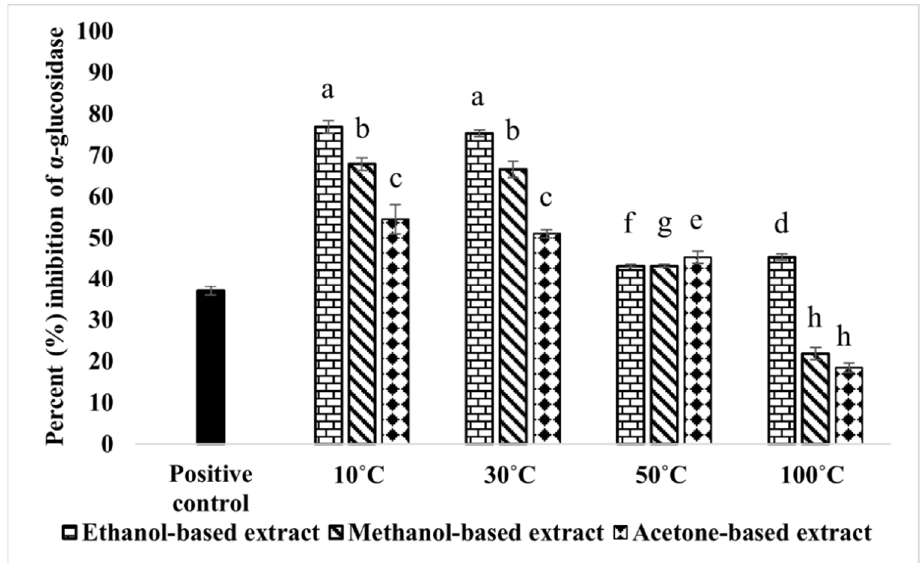
Figure 1. Effects of M. oleifera leaf extracts on α -glucosidase inhibition. The positive control was acarbose (10 mM). Bars displayed the mean based on 3 replicates of each treatment. Significant variations ( p < 0.05) among all extracts are represented by different letters (a–h) above the bars.